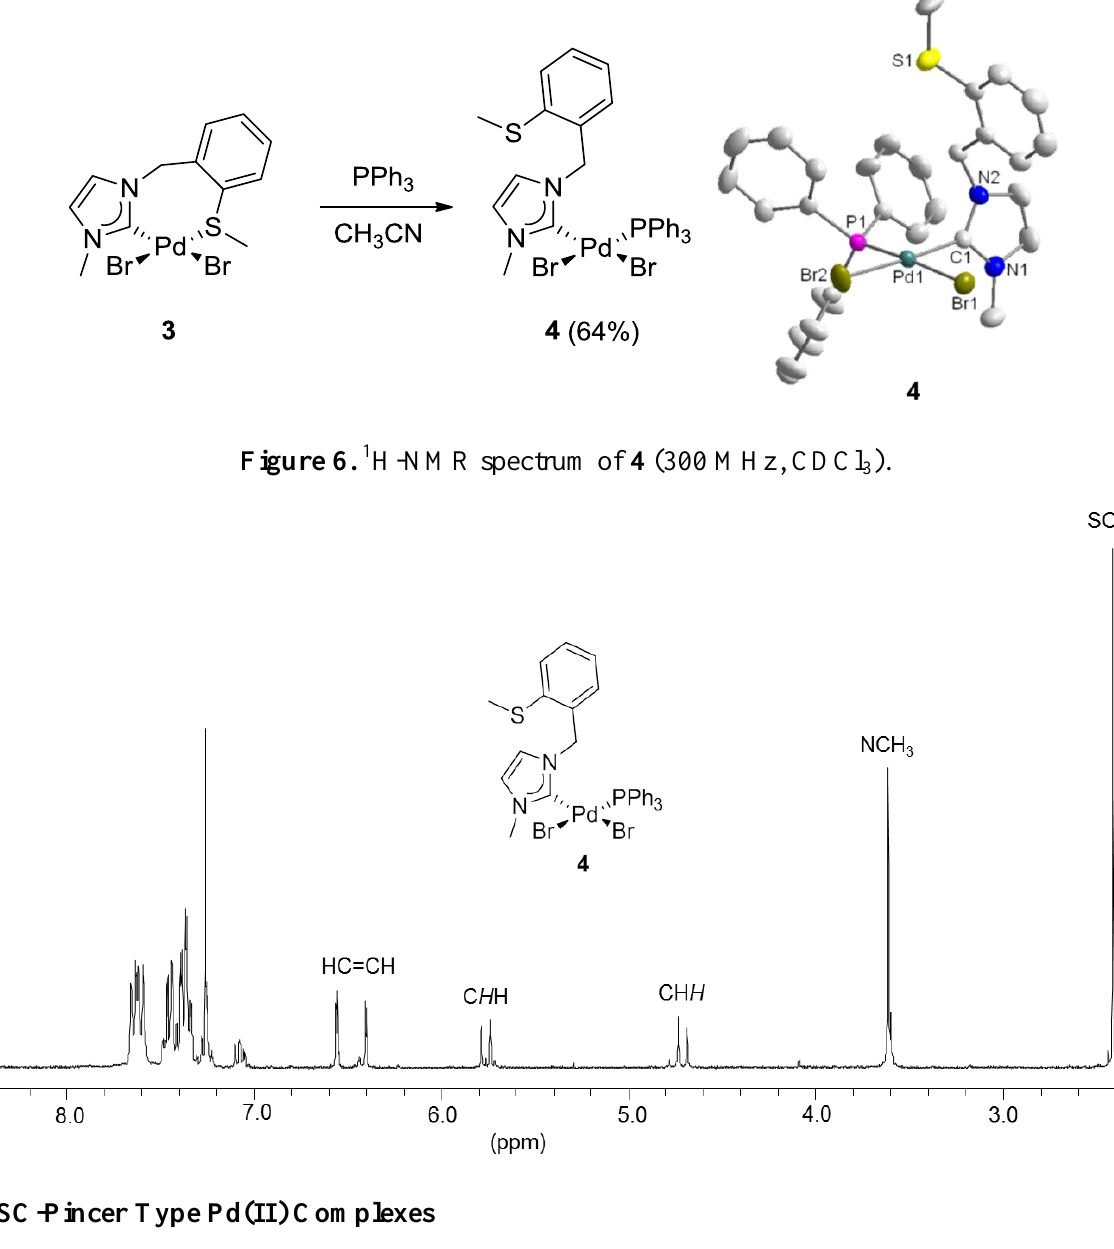
Figure 5. Synthesis of Pd(II) monocarbene complex 4 and its molecular structure [7,8].